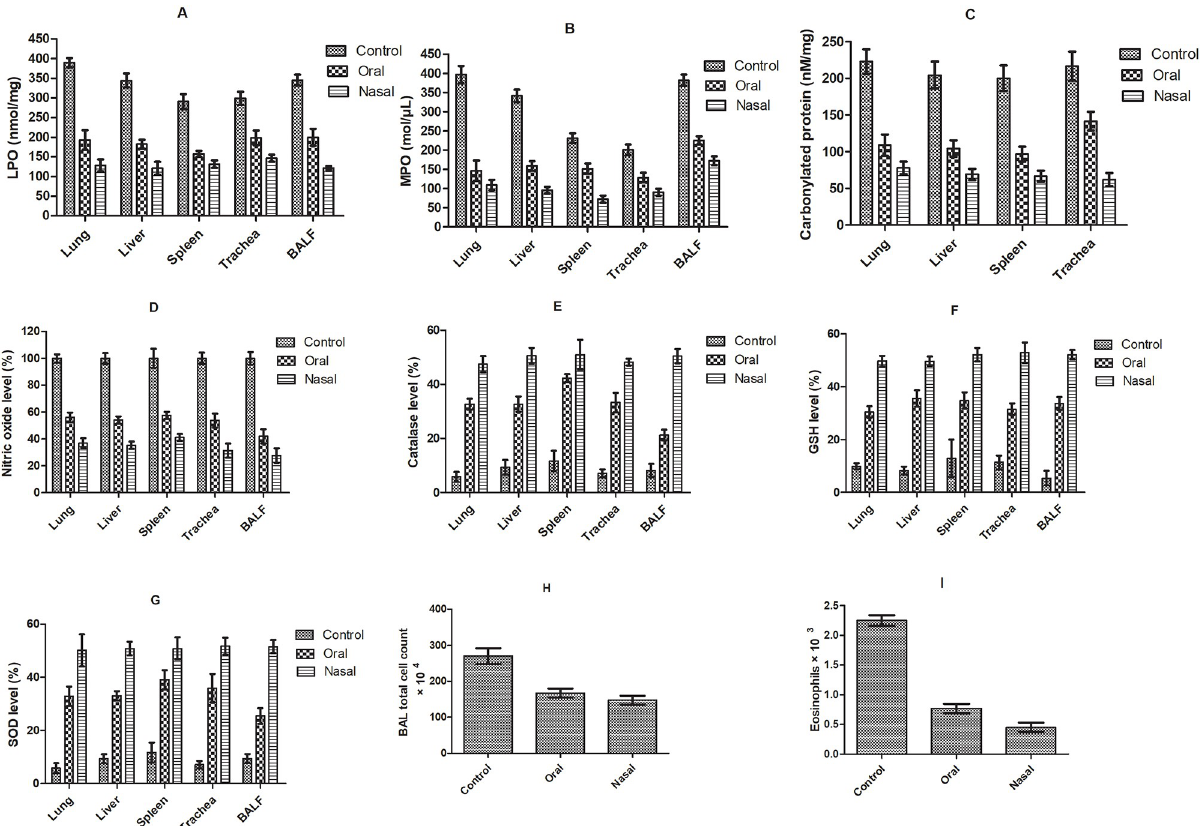
Fig 7. Effect of different treatments in OVA induced asthma model on (A) LPO, (B) MPO activity, (C) carbonylated protein content, (D) NO (%), (E) catalase (%), (F) GSH (%), (G) SOD (%) in lung, liver, spleen, trachea and BALF respectively; (H) BAL total cell count and (I) eosinophil count